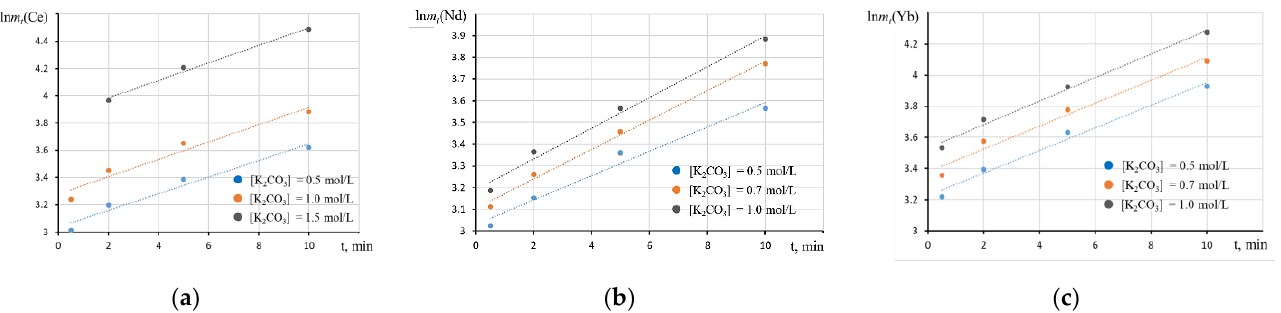
Figure 6. Time-dependent logarithm of weight obtained by dissolving lanthanide carbonate at a temperature of 20 °C: ( a ) for Ce; ( b ) for Nd; ( c ) for Yb.